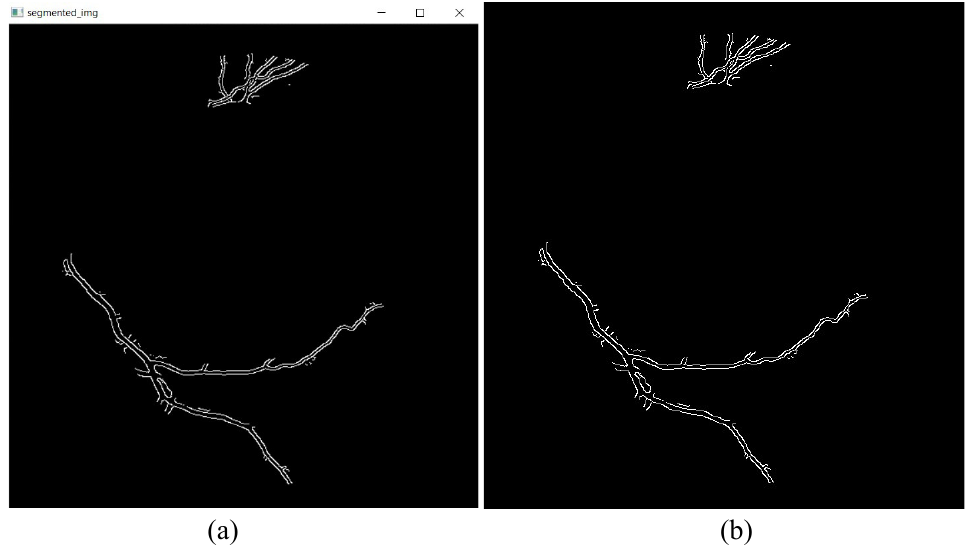
Figure 8. ( a ) Window displaying combination of all segmented parts. ( b ) Image created and saved as “segmented_img.jpg”